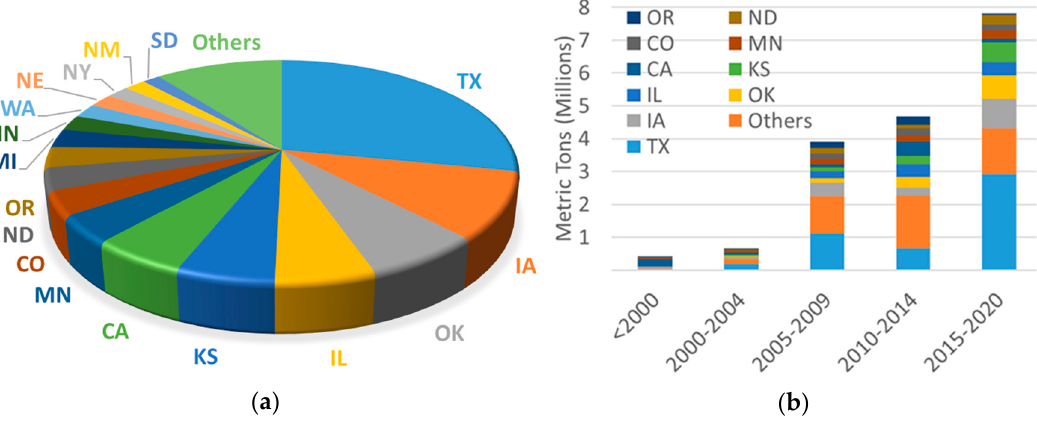
Figure 4. US—GoWInD ( a ) per state in decreasing order clockwise direction starting in Texas (TX), ( b ) over time considering installation year from before the year 2000 to 2020, with state classification.